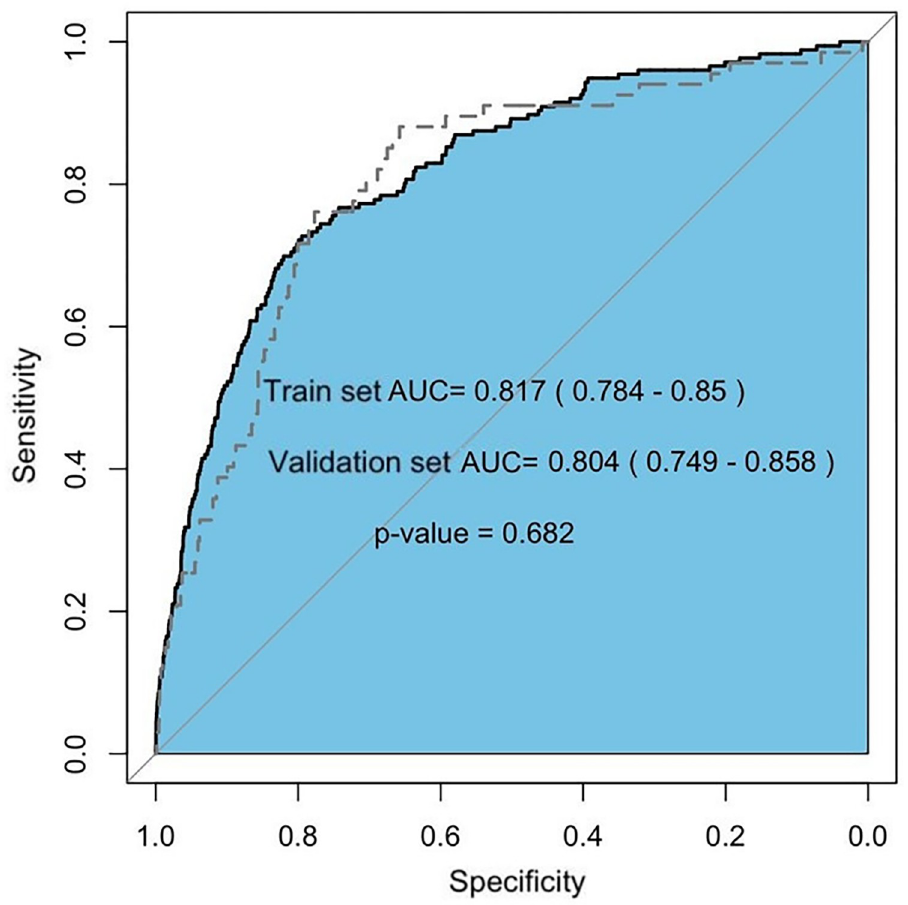
Fig 2. Relationships between the ROC of training set and validation